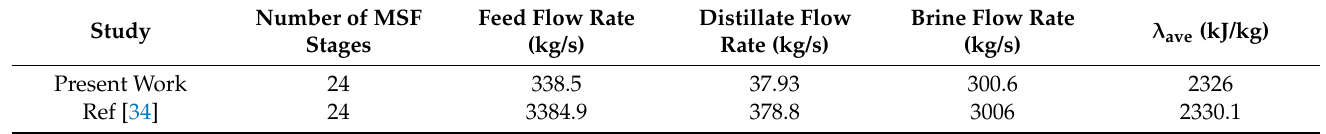
Figure 3. Comparison of effect of mass flow rate on thermal efficiency with published experimental work [50,51]. Table 6. Comparison of present study results with work of Eldessouky and Ettouney [34], to vali- date the MSF desalination subsystem. Study